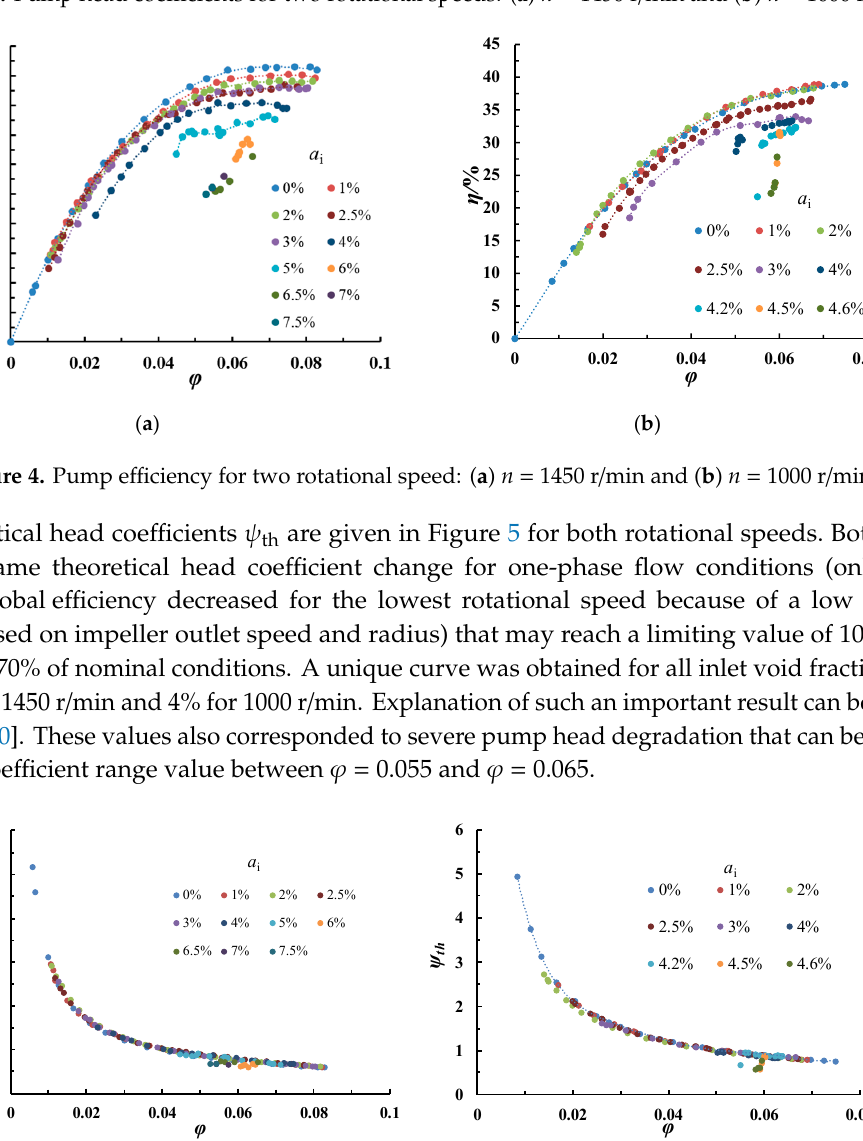
Figure 3. Pump head coefficients for two rotational speeds: ( a ) n = 1450 r/min and ( b ) n = 1000 r/min.